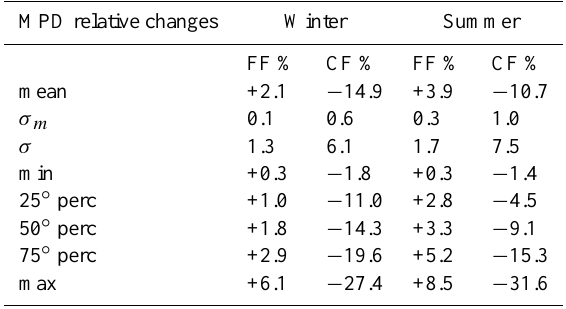
Table 2. Statistics for MPD changes measured during winter (DJF months; N profiles=142) and summer (JJA months; N pro- files=72). MPD changes are obtained comparing data above the mixing height with ground-level data. FF=Fine Fraction, CF=Coarse Fraction. σ =standard deviation, σ m = mean standard deviation.